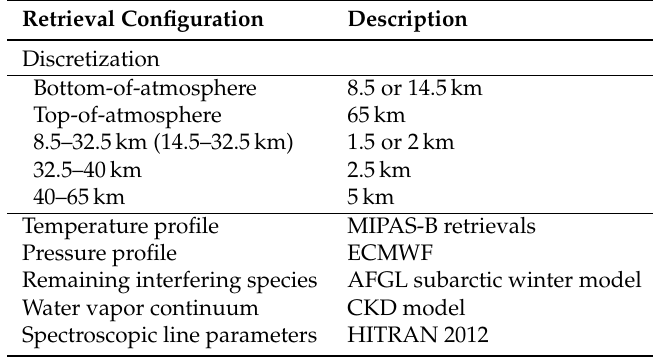
Table 1. Retrieval configurations for the reconstruction of atmospheric vertical concentration profiles from the TELIS limb spectra in the far infrared (FIR) region. The settings for the chosen retrieval grid, atmospheric inputs, and other forward model parameters are listed. MIPAS-B: Michelson Interferometer for Passive Atmospheric Sounding–Balloon; ECMWF: European Center for Medium-range Weather Forecasts; AFGL: Air Force Geophysics Laboratory; CKD: Clough–Kneizys–Davis; HITRAN: HIgh-resolution